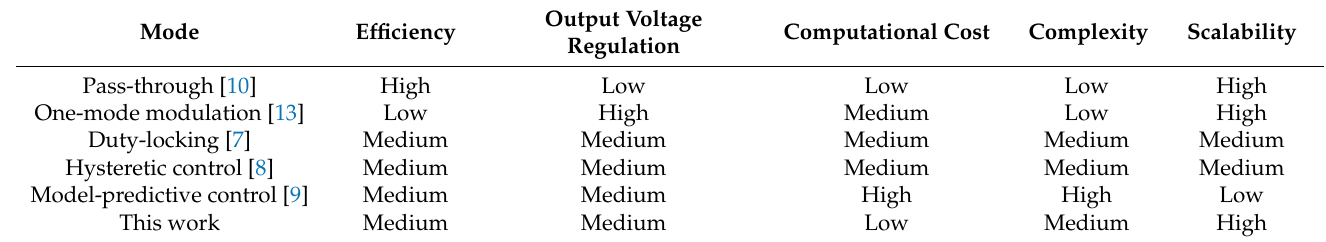
Table 8. Performance